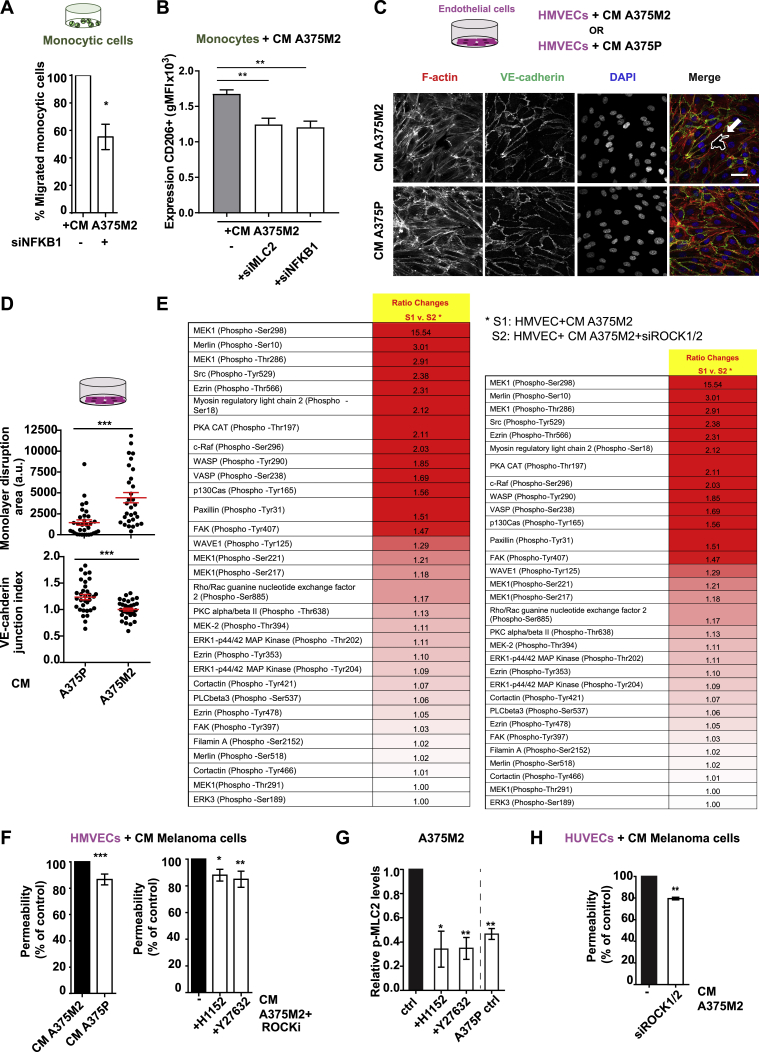
Metastatic Colonization via Amoeboid Melanoma Cell Secretion, Related to Figure 7(A) Migrated THP-1 cells toward CM A375M2 or CM from NFKB1-depleted A375M2 cells (n = 4).(B) gMFI for CD206 in macrophages after treatment with CM from MLC2-depleted or NFKB1-depleted A375M2 cells (n = 4).(C) (Top) Schematic showing treatment of endothelial cells with CM A375P or CM A375M2. (Bottom) Representative confocal images of VE-cadherin (green), F-actin (red) and DAPI (blue) immunostaining in HMVECs after treatment with CM A375P or CM A375M2. Dashed white lines represent gaps. Scale bar, 40 μm.(D) Quantification of monolayer disruption area (top) and VE-cadherin junctional index (bottom) in HMVECs after treatment with CM A375P or CM A375M2 (n ≥ 3).(E) Tables show the most upregulated phospho-proteins found in the cytoskeleton phospho-antibody array. HMVECs treated with CM A375M2 (s1) were compared to HMVEC cells treated with CM from ROCK1/2-depleted A375M2 cells (s2). Values are represented as ratio changes s1/s2. Ratio = (Signal Intensity of Phospho Site-Specific Antibody) / (Signal Intensity of Site-Specific Antibody). Results are highlighted in different shades of red which shows the highest expression levels. Fold-change increase is considered significant when the values are > 2.(F) Percentage of permeability of a confluent monolayer of HMVECs (left) treated with CM A375P or CM A375M2 and (right) treated with CM A375M2+H1152 or CM A375M2+Y27632 (n ≥ 3).(G) Relative p-MLC2 levels in A375P cells, A375M2 ± H1152 or ± Y27632 cells (n ≥ 3).(H) Percentage of permeability of a confluent monolayer of HUVECs treated with CM A375M2 (-) or CM from ROCK1/2-depleted A375M2. Data are presented as fold-change versus the control (n = 3).(A, B, D, and F–H) Graphs and dot blots show mean ± SEM. (A, D, F left, and H) t test. (F right) Kruskal-Wallis and Dunn’s multiple comparison. (B and G) One-way ANOVA with Tukey post hoc test.∗p < 0.05,∗∗p < 0.01,∗∗∗p < 0.001.